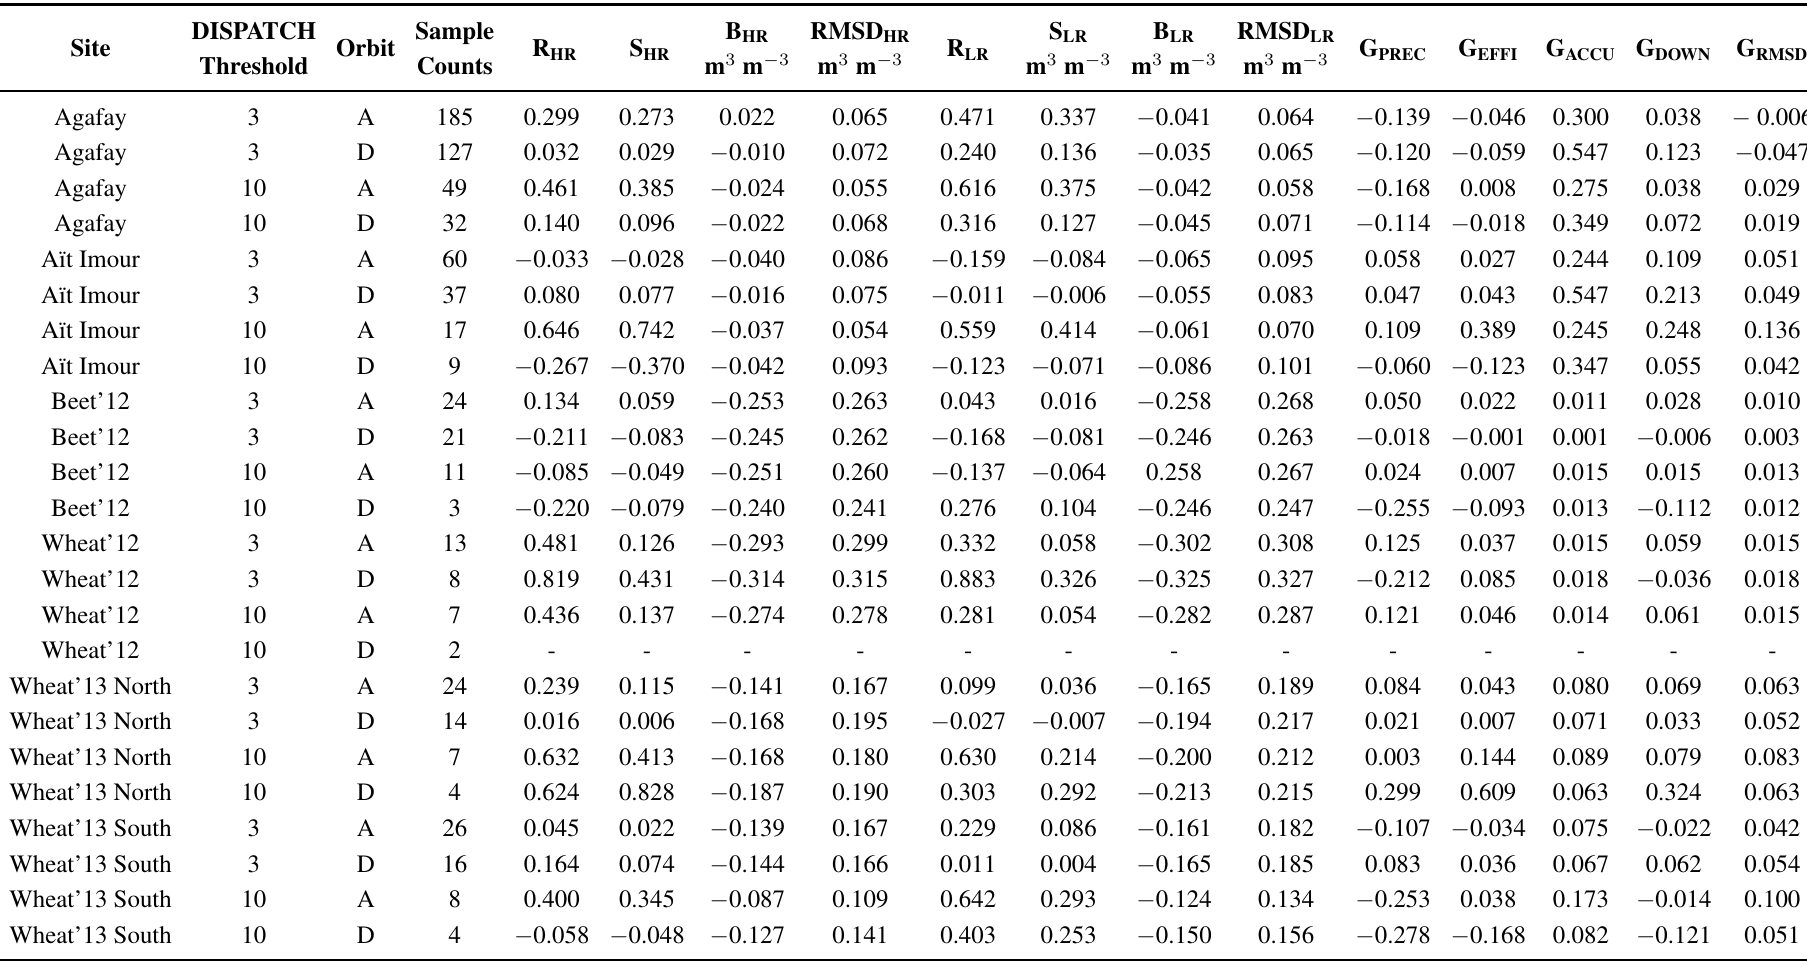
Table 3. Statistical results presented for each site, each SMOS orbit (A for ascending and D for descending) and two DISPATCH count thresholds (3 and 10),